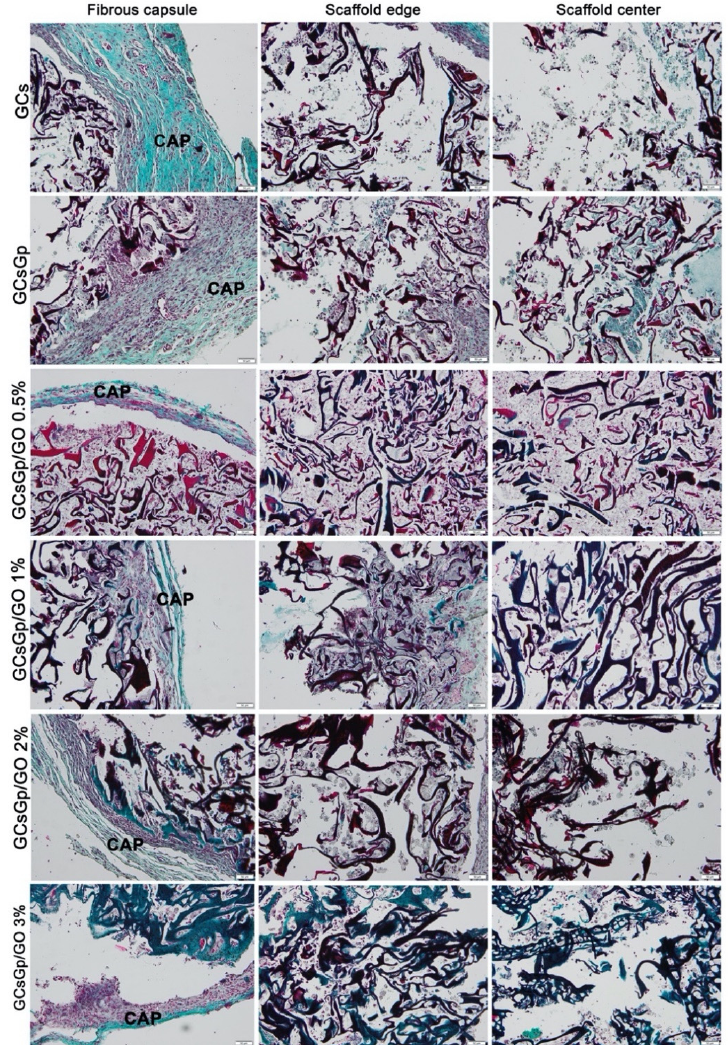
Figure 8. Light images of Gomori-trichrome-stained scaffolds at week 4 post implantation of GCs, GCsGp, GCsGp/GO 0.5%, GCsGp/GO 1%, GCsGp/GO 2%, and GCsGp/GO 3%, respectively, showing the varying thickness of the capsules, “CAP”, surrounding the di ff erent sca ff olds (first column), and the histological aspect of the edge and center of sca ff olds (second and third column, respectively). Collagen = green; scale bar = 50 µ